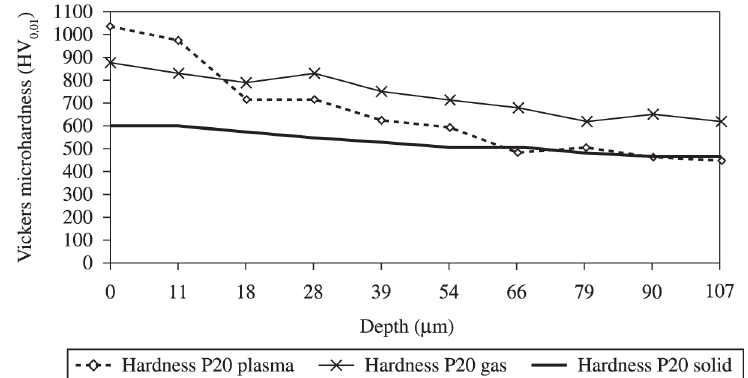
Figure 4. Microhardness profile for samples of AISI P20, nitrided by three different processes (plasma, gas, and solid (10h)).